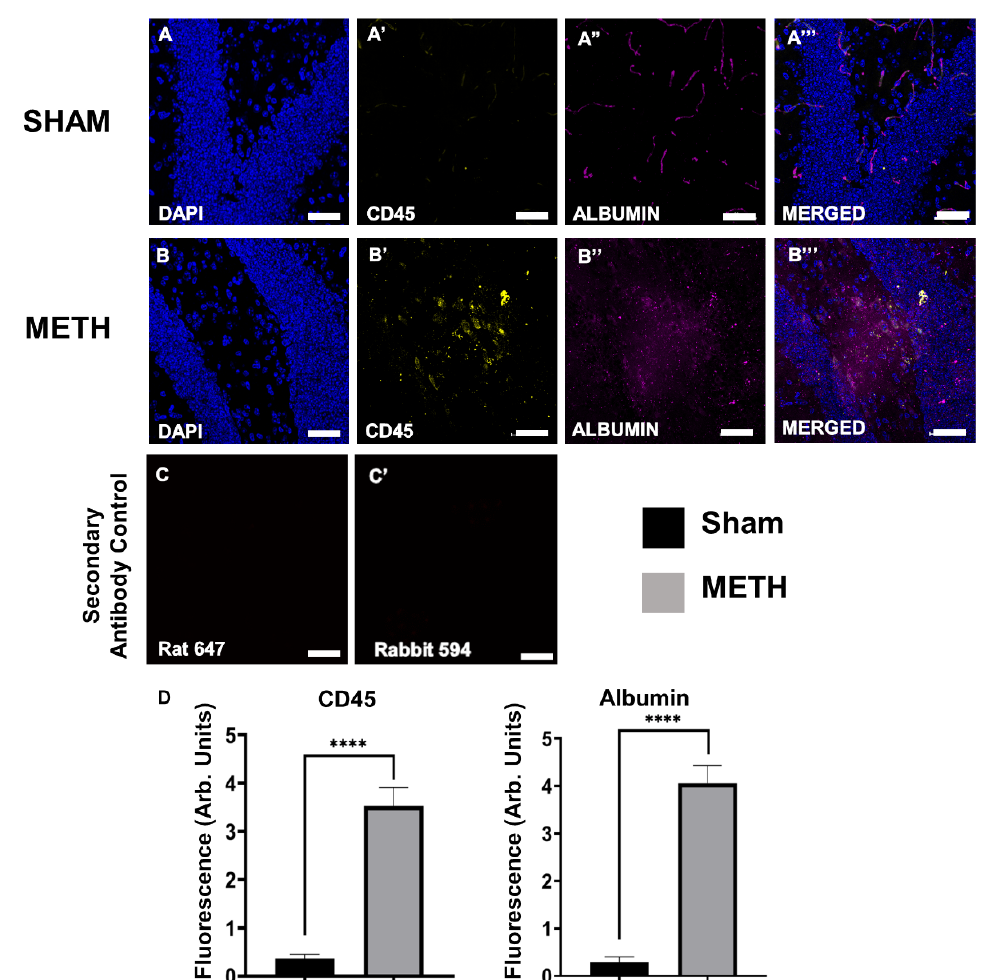
Figure 4. Acute METH exposure induces BBB permeability and inflammatory responses within the brain. Brain cross-sections of sham-treated ( A , A’ , A’’ , A’’’ ) and METH-treated ( B , B’ , B’’ , B’’’ ) mice. ( A , B ) DAPI nuclei, ( A’ , B’ ) immune cells labeled with pan-leukocyte marker, anti-CD45 antibody, ( A’’ , B’’ ) gut-derived albumin labeled with an anti-albumin antibody and, ( A’’’ , B’’’ ) merged images of DAPI, CD45, and albumin. ( C , C’ ) Secondary Antibody Control. The primary antibody was omitted to show the non-specific binding of the secondary antibody. Brain sagittal section level 10–15 using 15 μm intervals. Images captured at 40×, scale bar: 50 μm. ( D ) A significant difference between acute sham-treated and METH-treated mice in CD45 and albumin expression is shown. Results are expressed as mean ± standard error of the mean (SEM), **** p < 0.001.